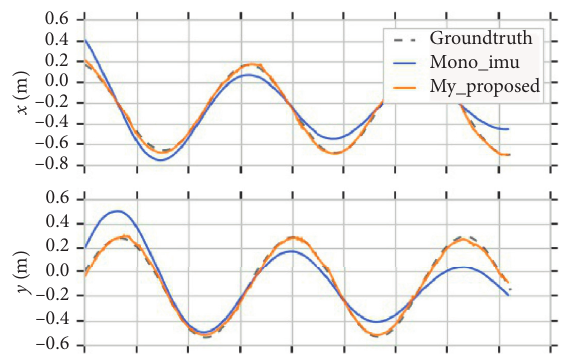
Figure 5: Comparison of x -axis and y -axis with true